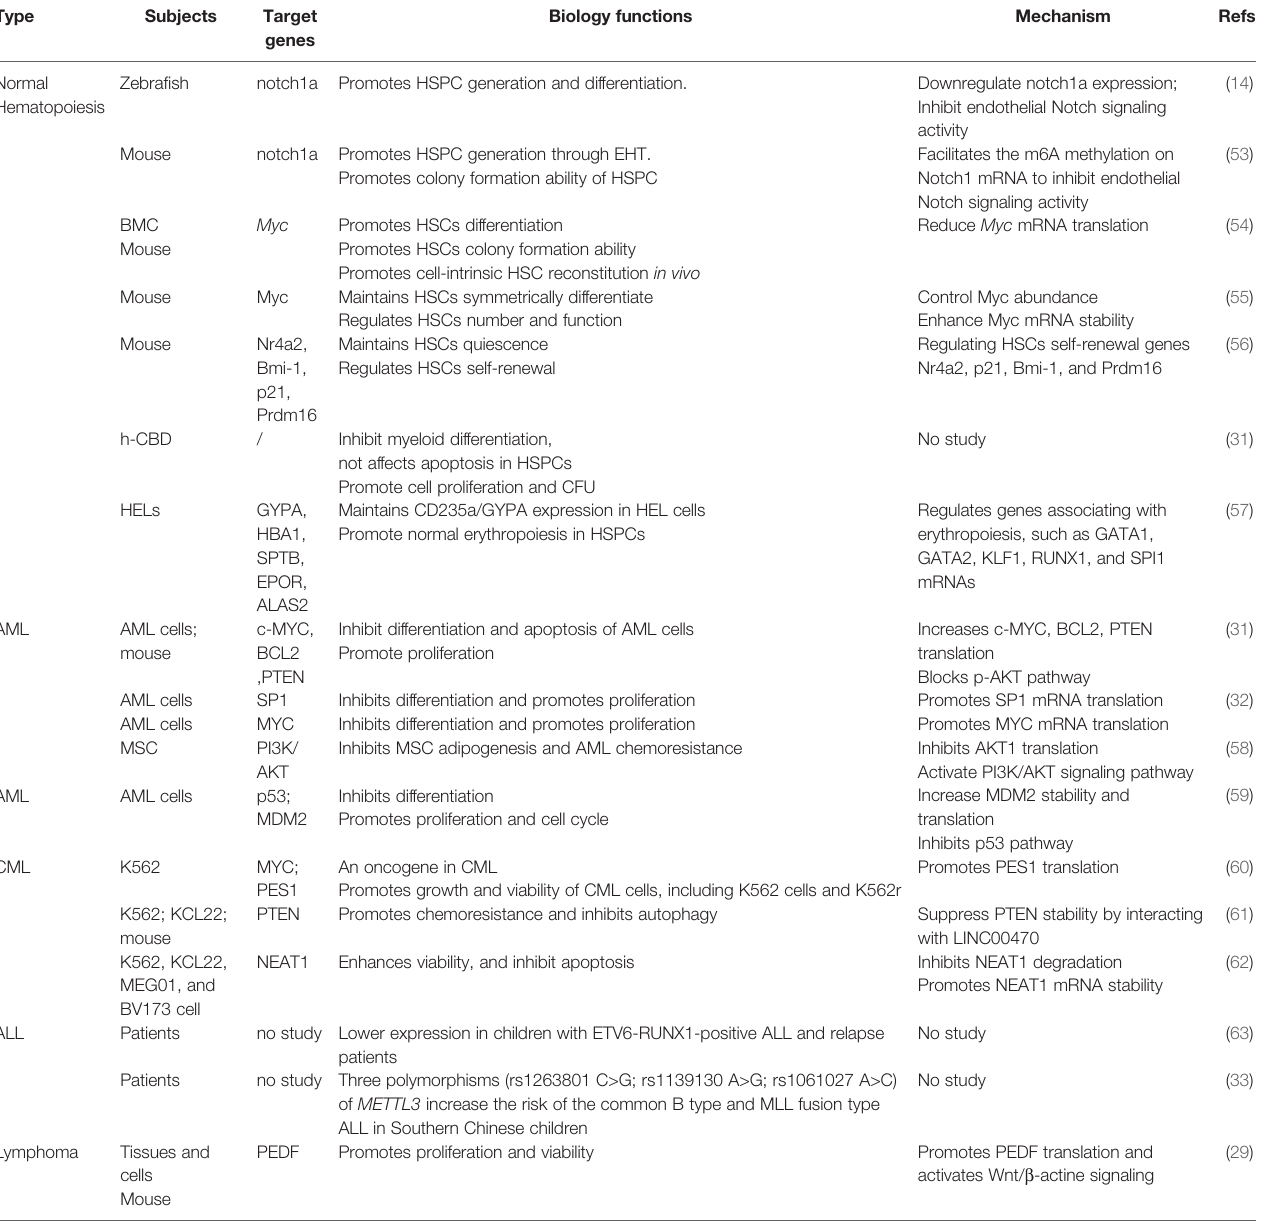
TABLE 1 | Role of METTL3 in normal and malignant hematopoiesis.